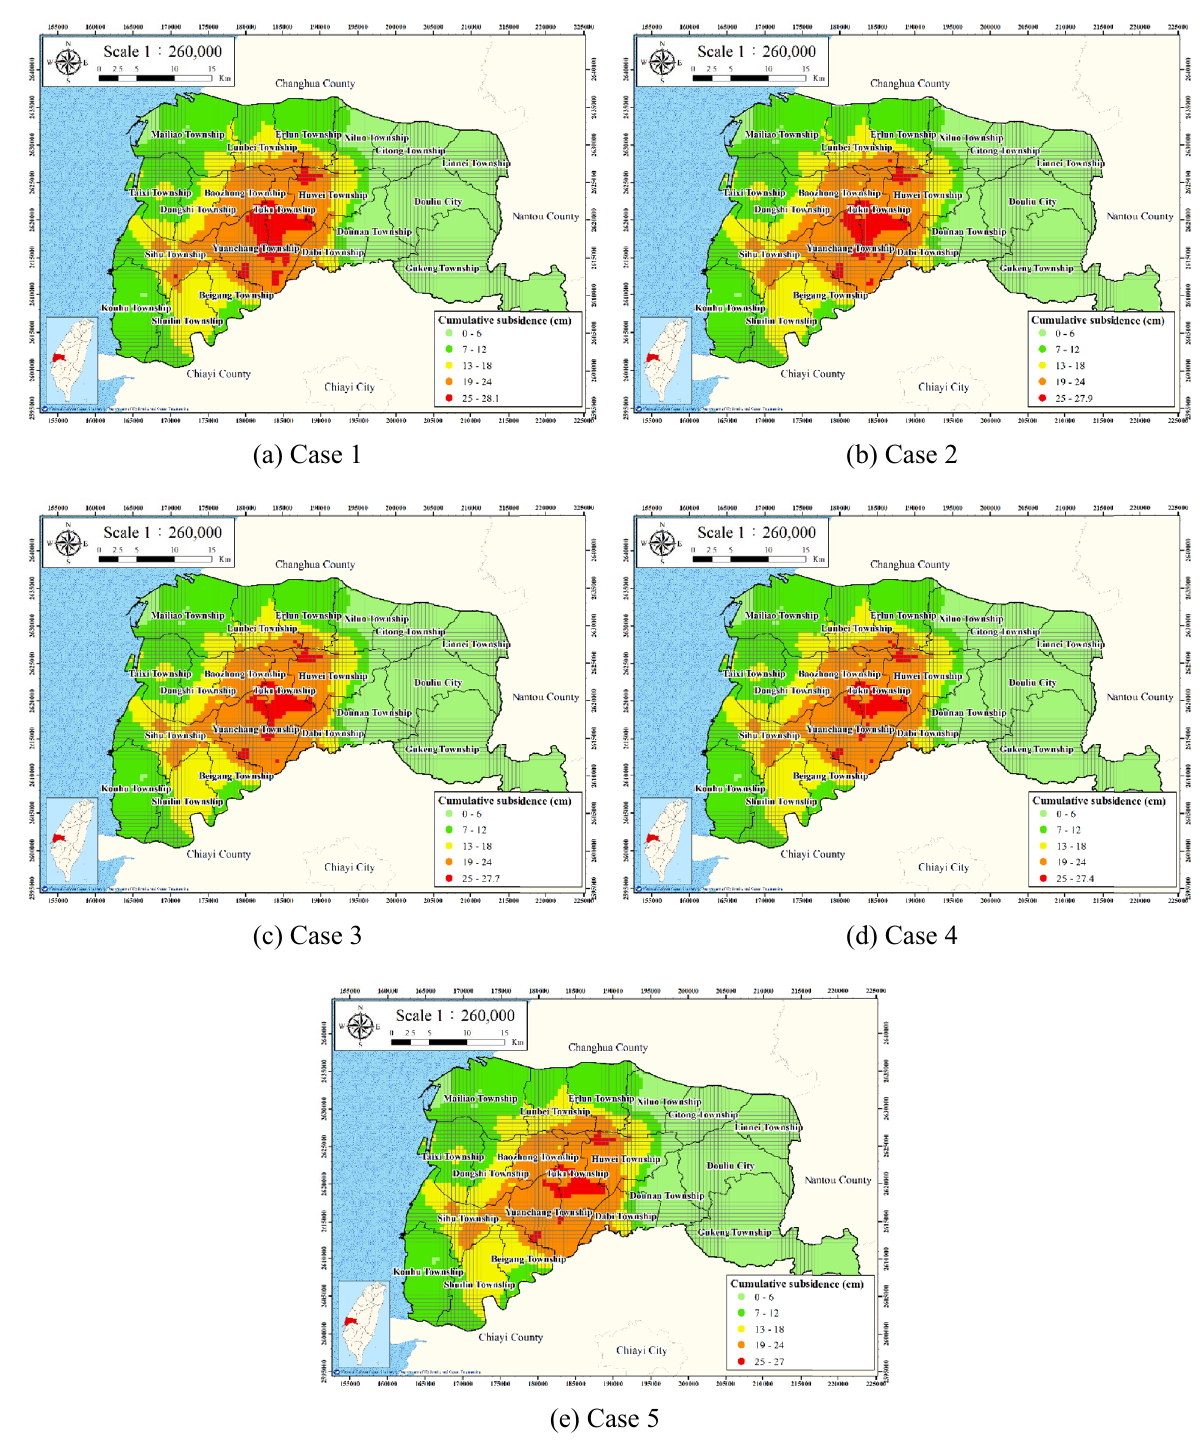
Figure 18. Land subsidence for each scenario. This figure was created using ArcGIS 10.6.1